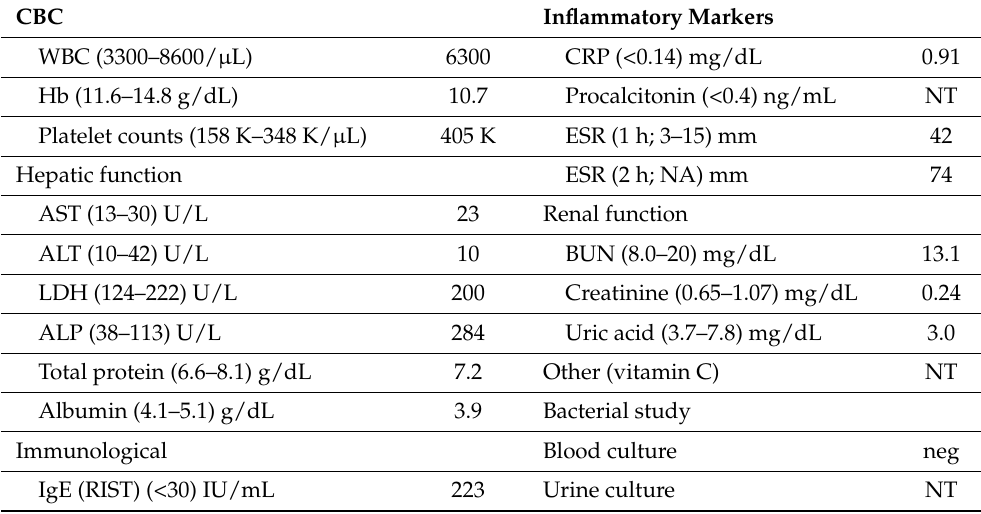
Figure 1. Computed tomography (( A ); coronal view) revealed a hyperostotic right mandible, with osteolytic and sclerotic changes associated with periosteal reactions. Magnetic resonance imaging (MRI; short tau inversion recovery (STIR); ( B ), axial view; and ( C ), coronal view) showed a low-dense hyperostotic right mandible, associated with an inflamed right masseter muscle and wing pterygoid muscle (arrows). Table 1. Laboratory